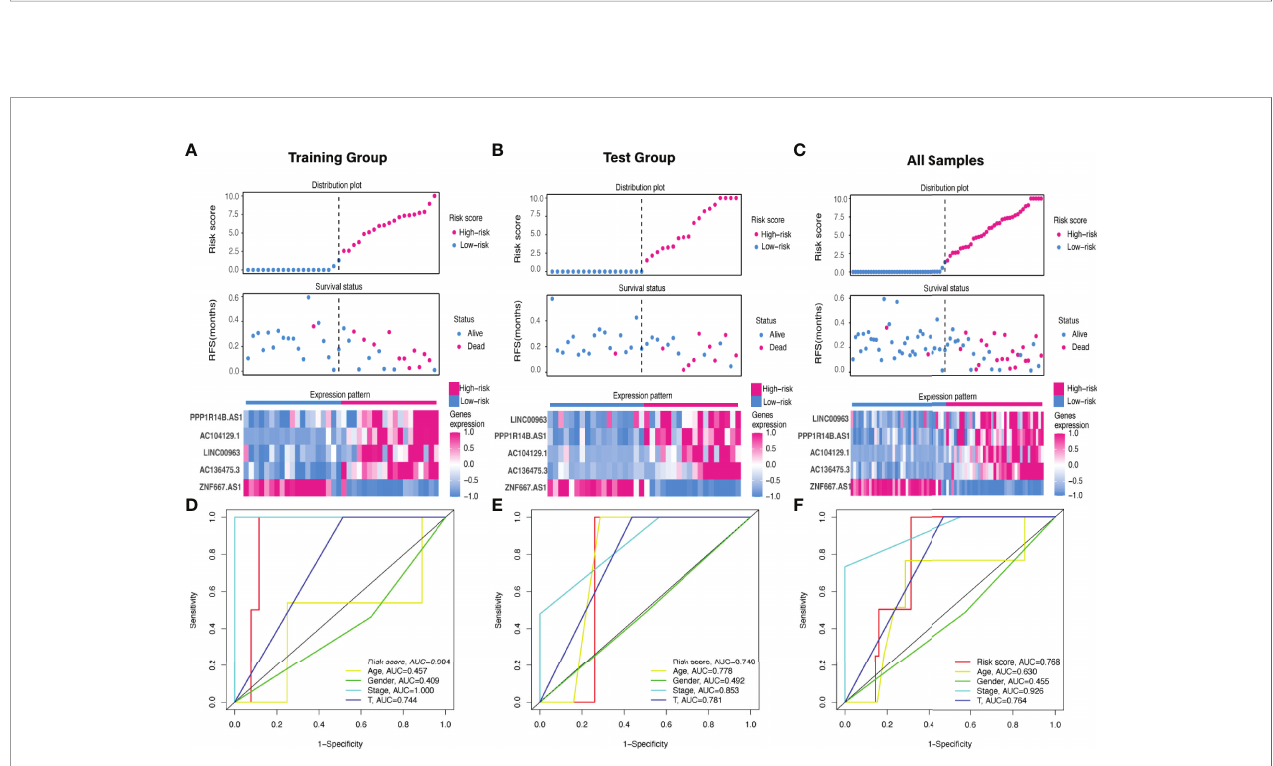
FIGURE 4 | The K-M survival curve and ROC curve of risk score based on fi ve FRLs signature. (A – C) Differences in the overall survival of UM patients between the high- and low-risk groups in the (A) training, (B) test, and (C) all cohorts. (D – F) ROC curves of risk scores at 1, 2, and 3 years in the (D) training, (E) test, and (F) all sets.